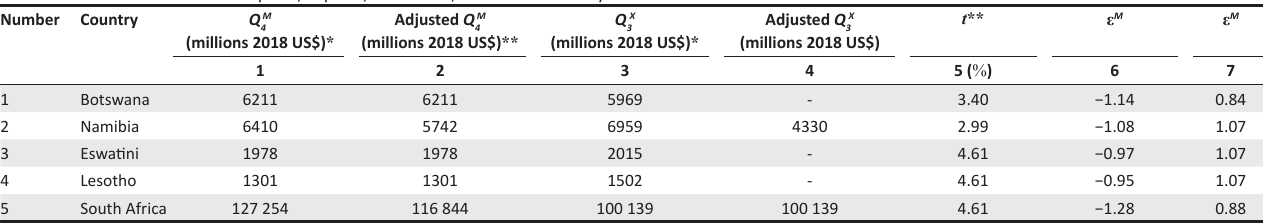
TABLE 1: Value of merchandise imports, exports, tariff rates, and trade elasticity. Number Country Q 4M Adjusted Q 4M (millions 2018 US$) * (millions 2018 US$)